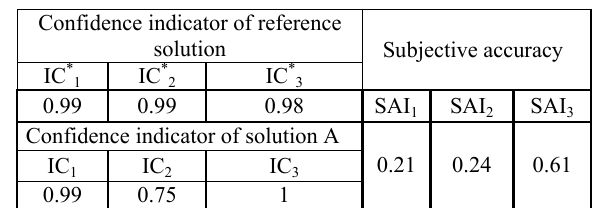
Table 5.The confidence indicators (IC 1 ,IC * 1 ) and the sub– jective indicators (SAI 1 ) of solution